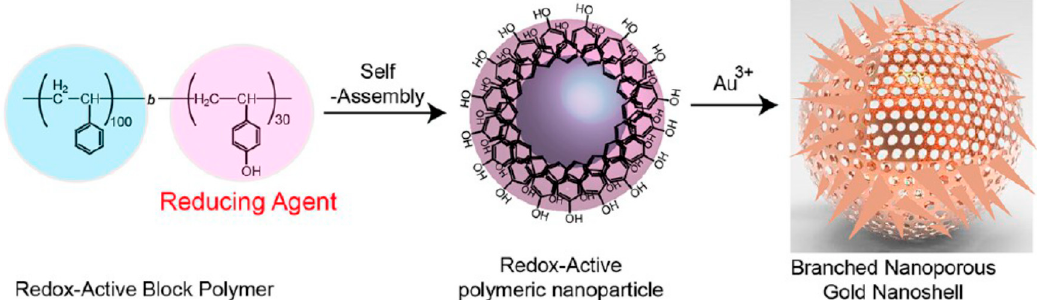
Figure 9. Schematic representation of the production of multibranched-hollow gold nanoparticles, based on self-assembled polymer template. Reproduced from [67] with permission from the American Chemical Society.